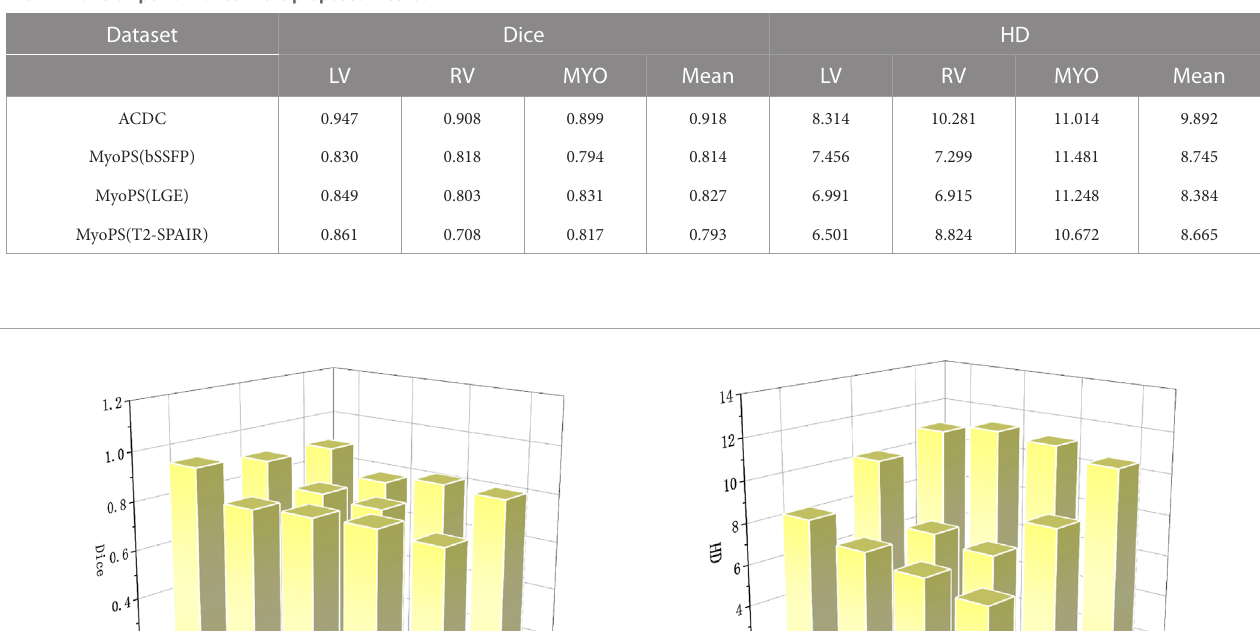
TABLE2 Overallperformanceoftheproposedmethod.